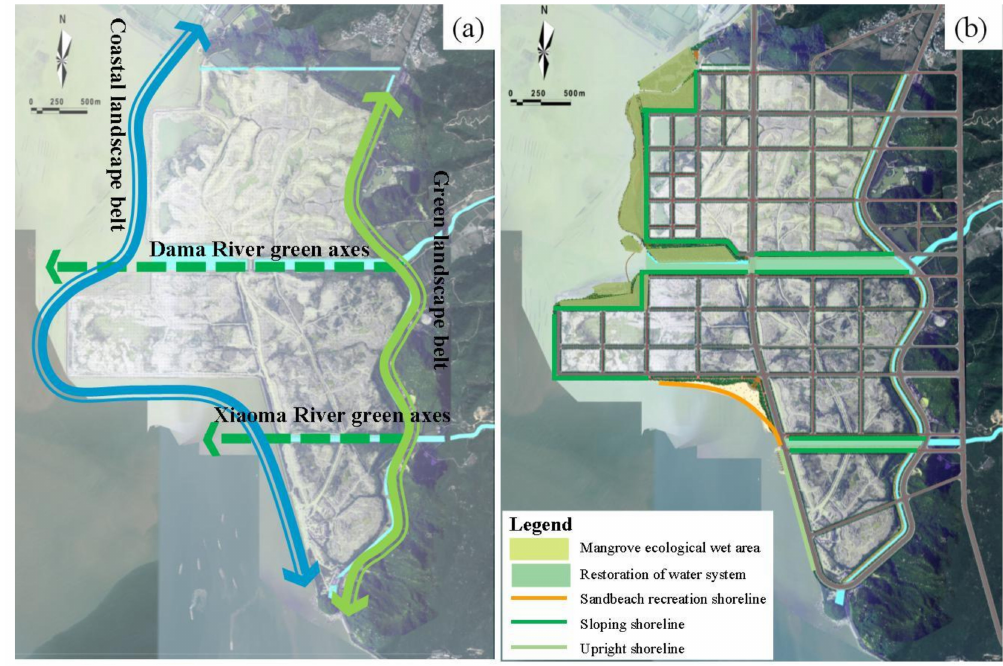
Figure 8. Restoration space pattern: ( a ) landscape structure and ( b ) ecological restoration.